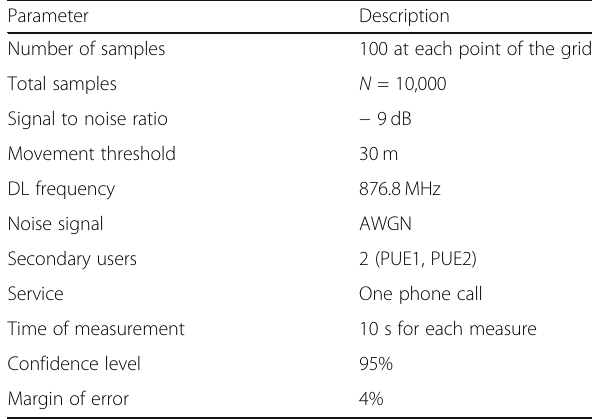
Table 5 Parameters for motion